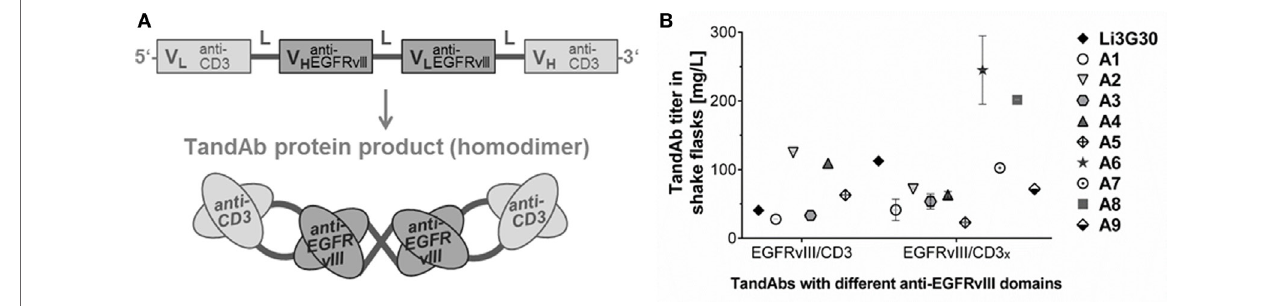
FigUre 1 | Design, production, and purification of recombinant egFrviii-targeting tandem diabodies (Tandabs) . (a) Scheme of the gene design, domain order, and postulated folding by dimerization of tetravalent bispecific EGFRvIII/CD3 TandAbs. The gene arrangement is shown from 5 ′ to 3 ′ -end encoding the monomeric polypeptide. N-terminal signal peptide and C-terminal His tag are not shown. (B) Expressability of different classes of EGFRvIII-targeting TandAbs containing different T-cell-binding moieties, CD3 (human CD3-specific), or CD3 x (human/cynomolgus cross-reactive), and EGFRvIII-binding moieties was analyzed at research stage in shake flasks. For candidates expressed more than once, mean titers are plotted with error bars indicating